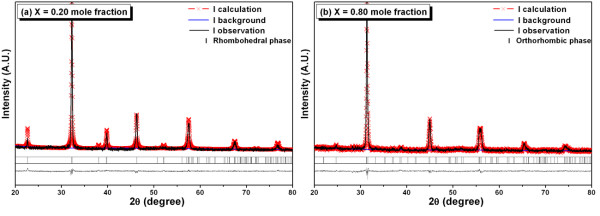
Refinement of Bi0.5Na0.5Ti1-xZrxO3 ceramics. The refinement at (a) 0.20 mole fraction and (b) 0.80 mole fraction showed a rhombohedral phase and an orthorhombic phase, respectively.